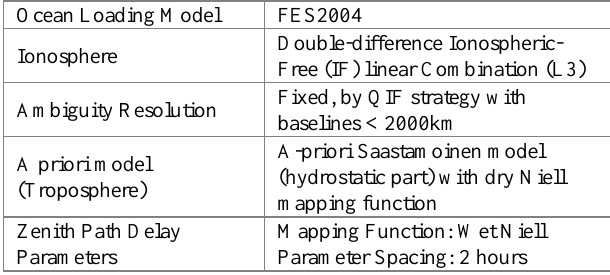
Table 1. Processing strategy and parameters used for Bernese